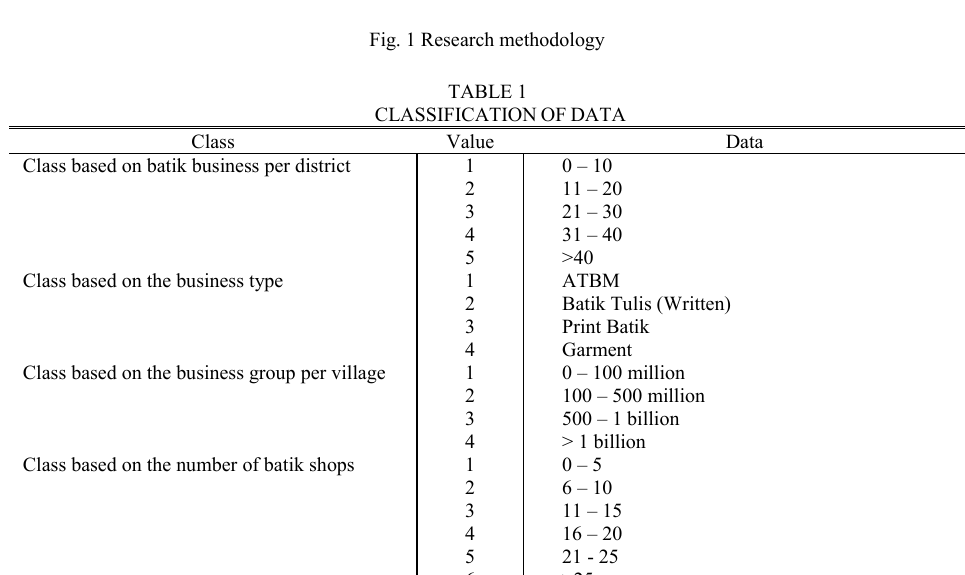
Fig. 1 Research methodology TABLE 1 CLASSIFICATION OF